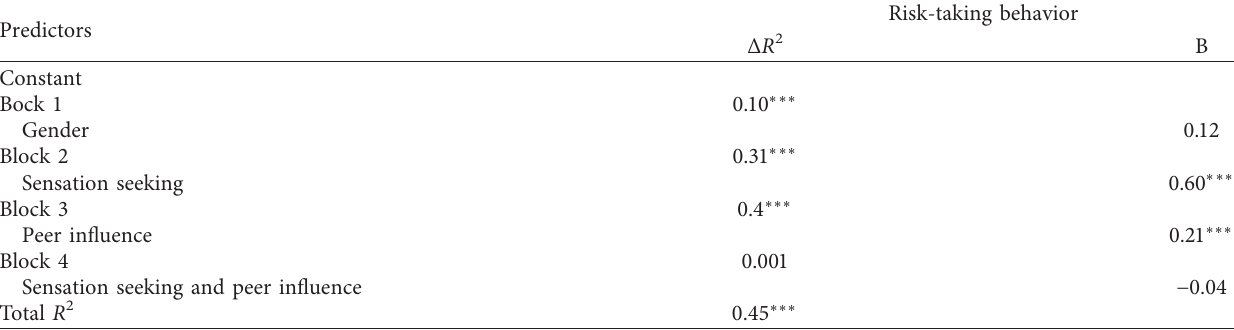
Table 3: Multiple hierarchical regression (moderation) analysis predicting risk-taking behavior from sensation seeking and peer influences ( N �